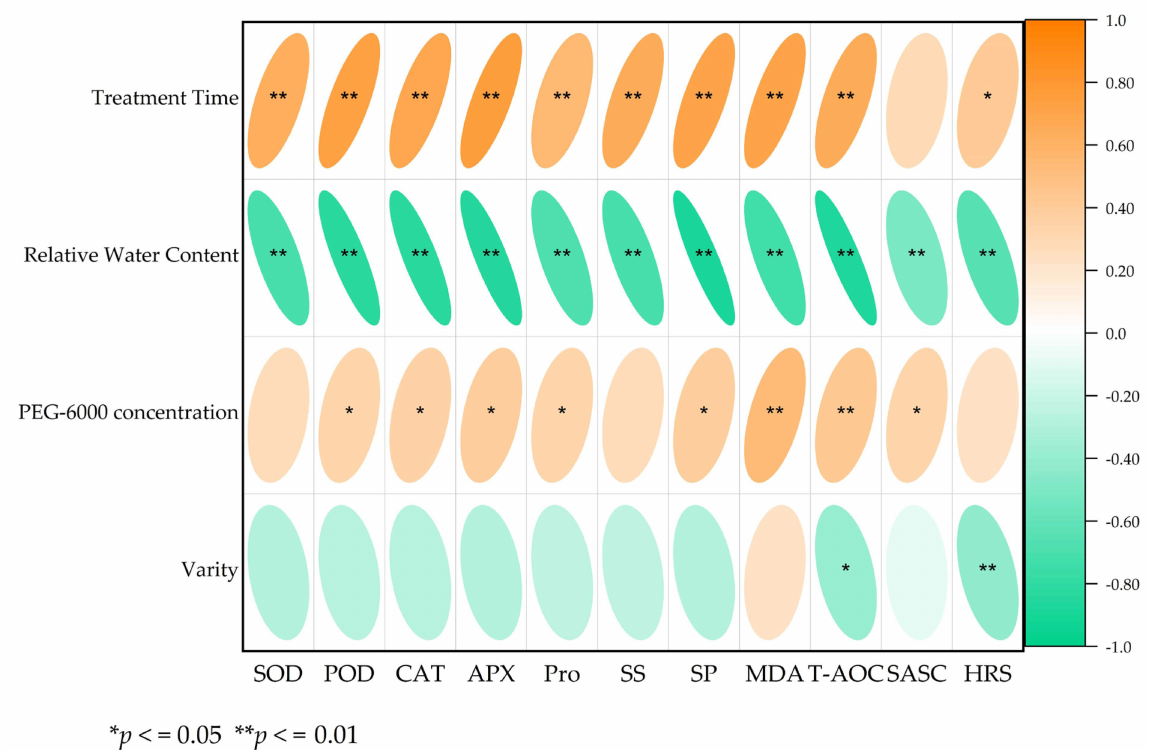
Figure 7. Correlation analysis between different physiological indexes and treatment time, RWC, PEG-6000 concentration and